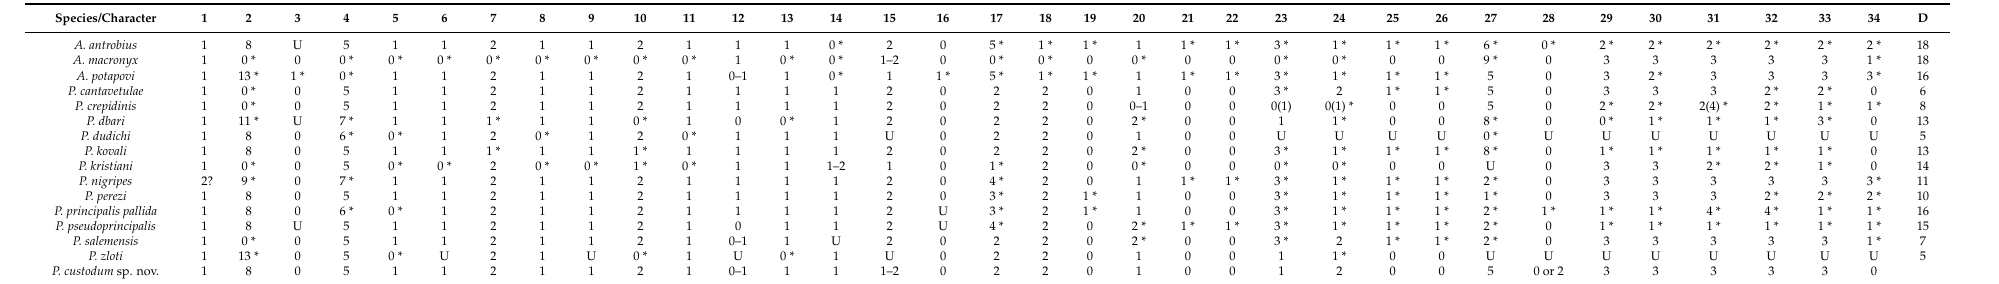
Table 2. Comparison among the species that share with P. custodum Baquero and Jordana sp. nov. the presence of the reduced distal formula 021 for the dens (number of ventral– external–internal spine–like chaetae); or one eye + eight spine–like chaetae on head vertex; or a 0 chaeta not bifurcated + at least a 1 winged and serrated at the base on female anal